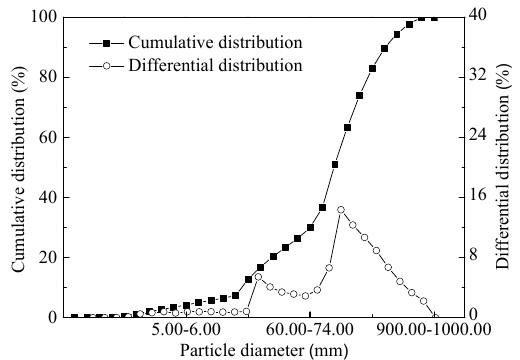
Figure 1. Particle size distribution of raw HCVTM concentrate.